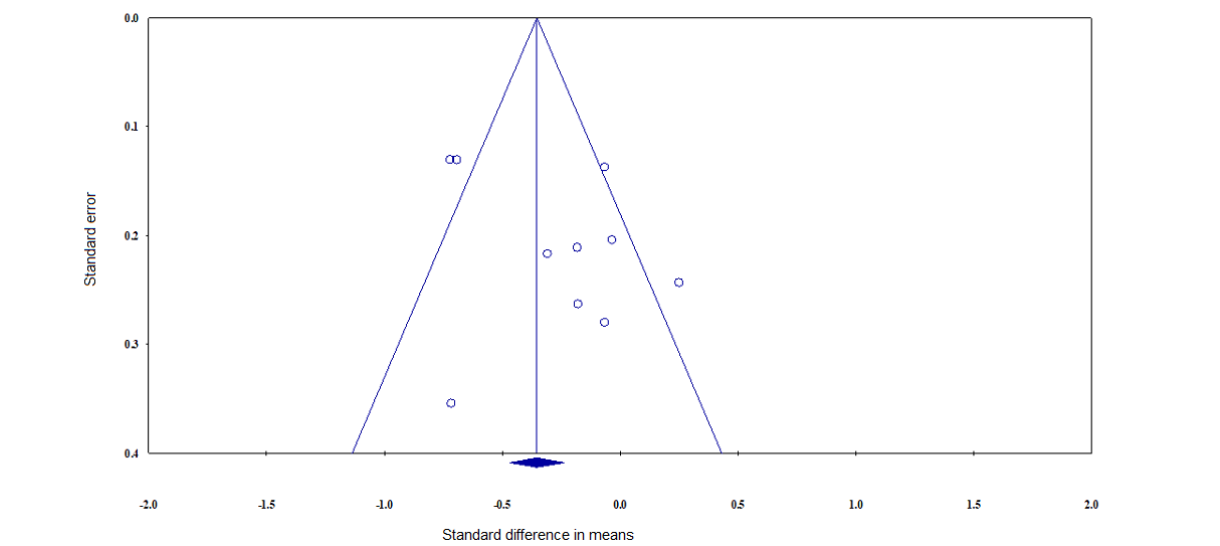
Figure 6. Funnel